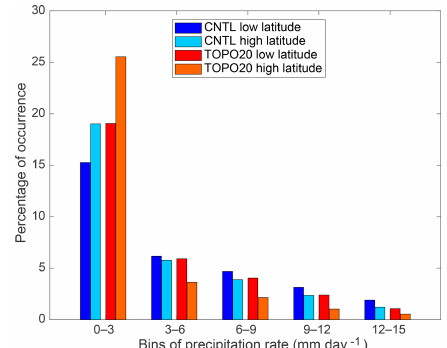
Figure 15. Relative occurrence (%) of summer daily precipitation rates on the Tibetan Plateau for lower latitudes (averaged over 30– 32 ◦ N, 85–100 ◦ E) and higher latitudes (averaged over 34–36 ◦ N, 85–100 ◦ E). Only two elevation scenarios (CNTL and TOPO20) are shown here as the other scenarios are identical to these two. Low precipitation rate events are more frequent at higher latitudes than at lower latitudes under all elevation scenarios. See Fig. 13 for a demonstration of how this rainfall distribution impacts δ 18 O p